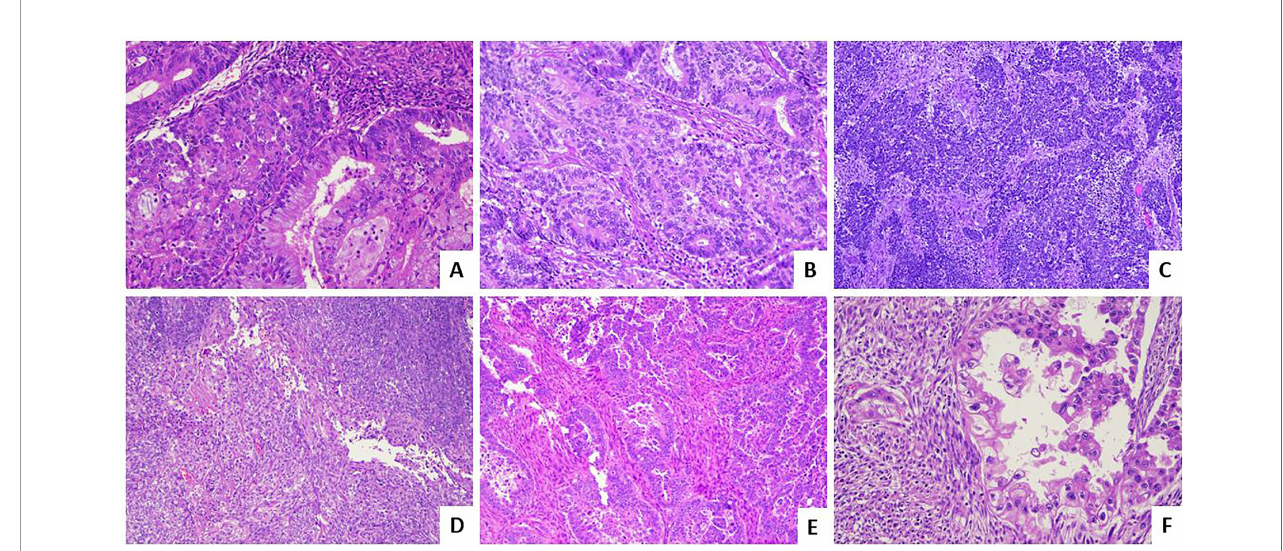
FIGURE 1 | Histological subtypes of endometrial carcinoma: an overview. (A) An endometrioid carcinoma G1 FIGO with mucinous features (LSAB, 10×). (B) An endometrioid carcinoma G2 FIGO (LSAB, 10×). (C) An endometrioid carcinoma G3 FIGO with basaloid features (LSAB, 4×). (D) An endometrioid carcinoma G3 FIGO with spindle cell features (LSAB, 4×). (E) A serous carcinoma (LSAB, 10×). (F) A clear cell carcinoma (LSAB,